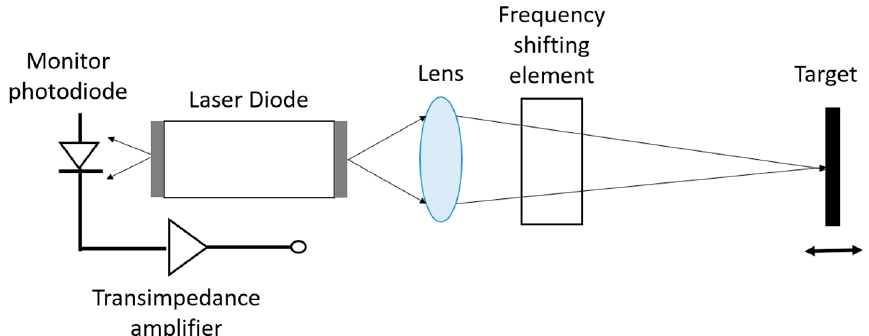
Figure 14. A schematic configuration of a self-mixing heterodyne LDV.